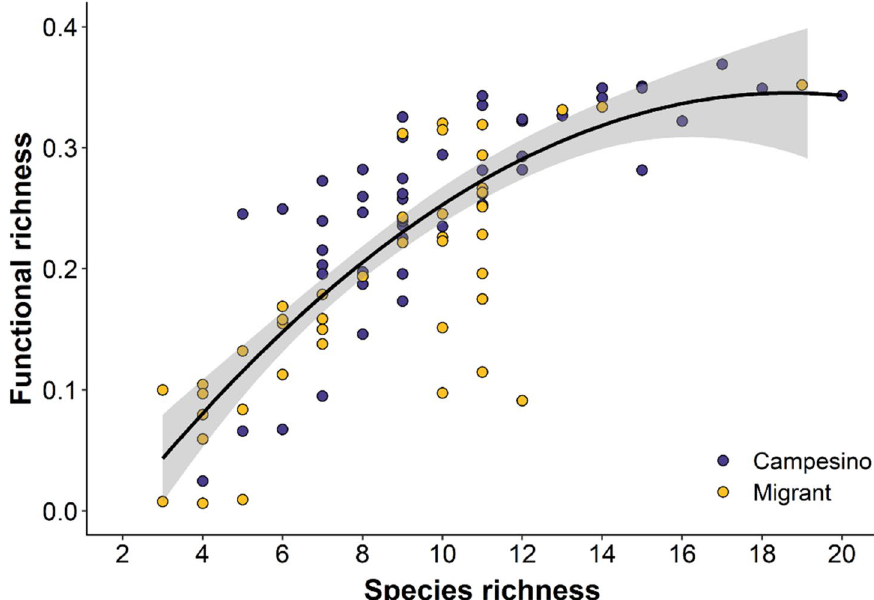
Figure 1. Estimated association between species richness and functional richness for 50 campesino (blue dots) and 50 migrants (yellow dots) homegardens for 85 species in beetle communities in Andean temperate ecosystems, southern Chile. Graphs were generated using R software version 4.0.4 (R Core Team, 2021. R: A language and environment for statistical computing. R Foundation for Statistical Computing, Vienna, Austria. https:// www. Rproj ect. org/).